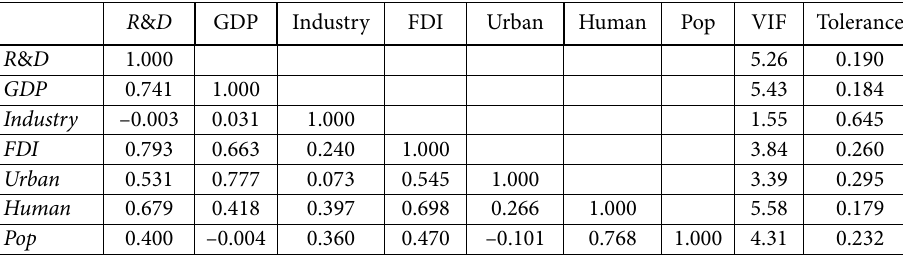
Table 3. Data descriptive statistics and correlation